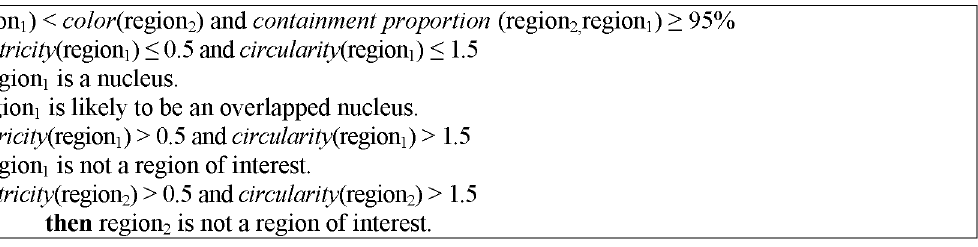
Fig 8. Decision rules to identify